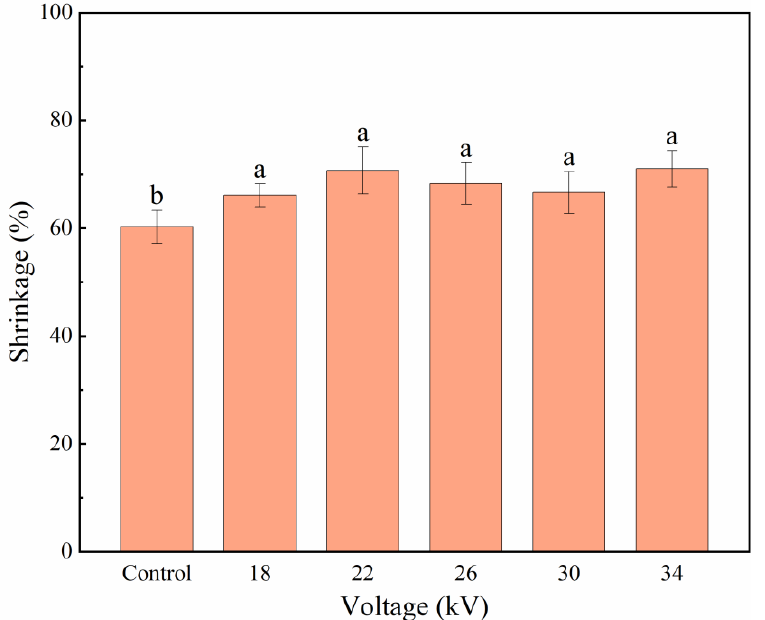
Figure 6. Shrinkage of shiitake mushroom slices. Different letters indicate significant differences ( p < 0.05) between sample means. ( p < 0.05) between sample